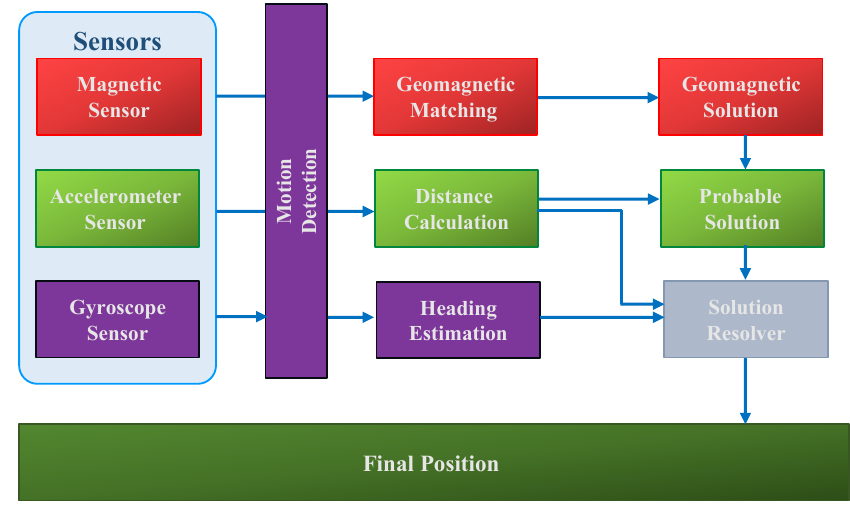
Figure 3. The proposed system block